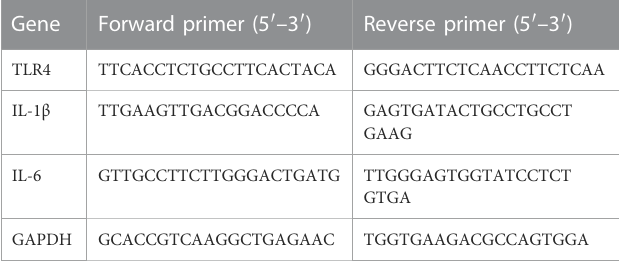
TABLE 1 The prime sequences of all genes used in